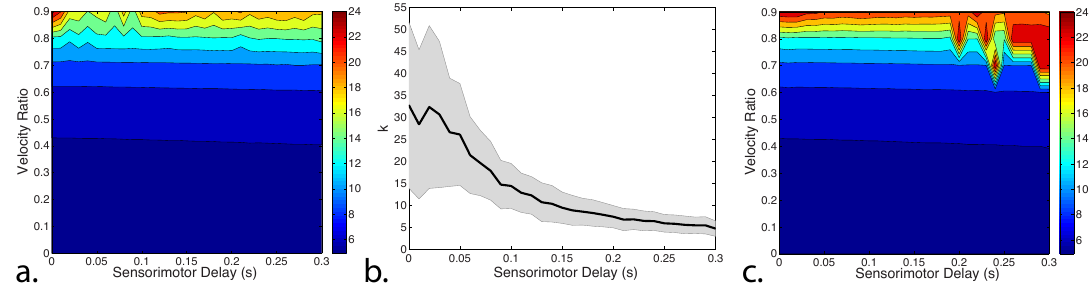
Figure 18. ( a ) The time to interception when varying the sensorimotor delay and the velocity ratio of a moving target using the pursuit strategy. The proportional (P) gain is optimized between 0.5 and 50 for each velocity ratio, and for various delays spanning the range (0, 0.3) s. The bar on the right provides a key for the time to interception (0, 24) s; ( b ) The effect of sensorimotor delay on P gain. The black line represents the mean P value over all velocity ratios for each sensorimotor delay. The grey shading represents the standard deviation around the mean P gain; ( c ) The time to interception when varying the sensorimotor delay and the velocity ratio of a moving target using the pursuit strategy. The mean P gain (see ( b )) for each delay is used. The bar on the right provides a key for the time to interception (0, 24) s. Reproduced with permission from [143].